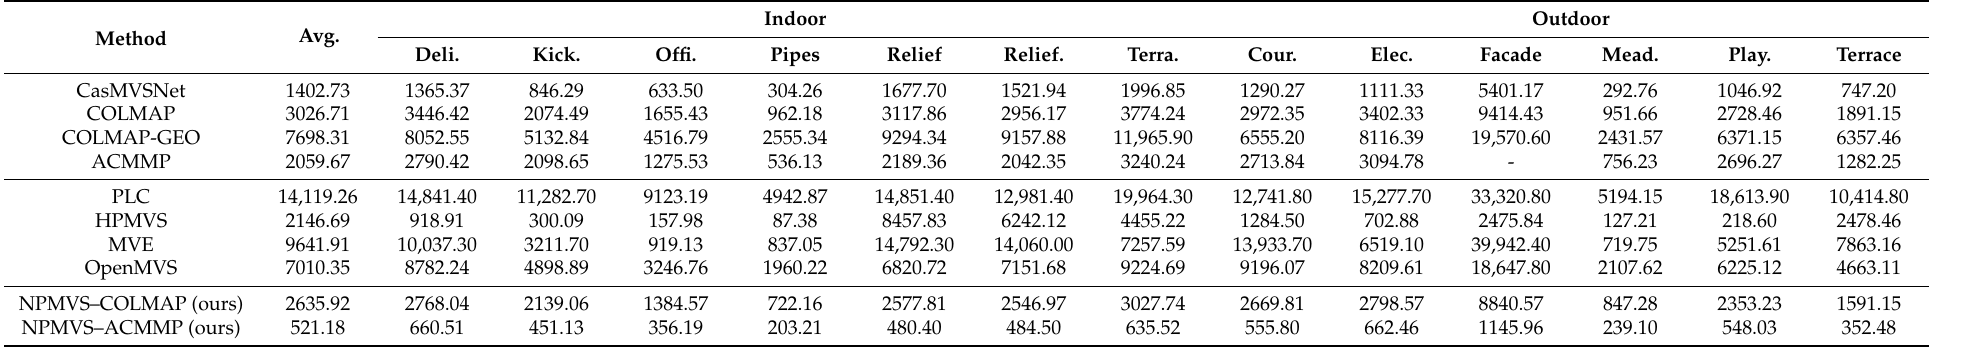
Table 1. Comparison of time (s) (lower is better).